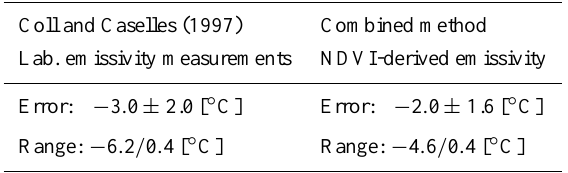
Table 2. Validation results for the Walpeup wheat crop data set (Prata, 1994b). T g , T a , and T s are the ground, air, and retrieved sur- face temperature, respectively. T s was obtained using the combined